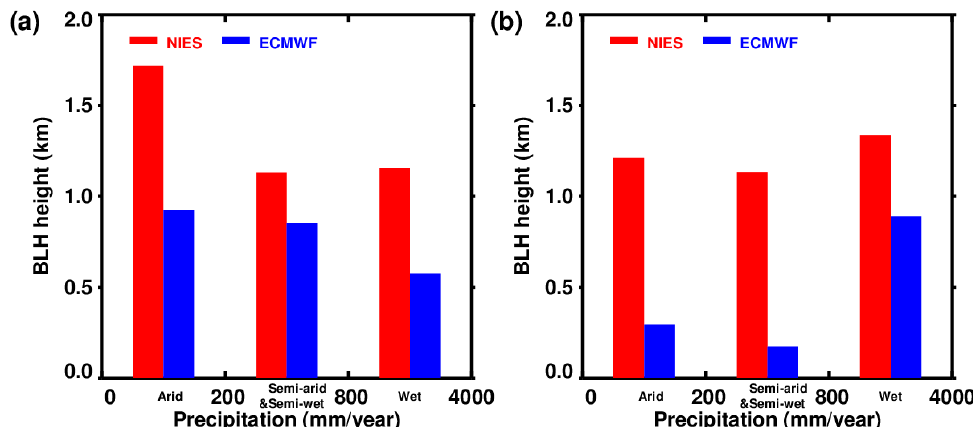
Figure 9. Comparison of AD-Net (red) and ECMWFs (blue) PBL in the case of different climate conditions (arid, semi-arid and semi-wet, and wet) for summer ( a ) and winter ( b ). Table 4. Mean differences in BLH between AD-Net and ECMWFs (ECMWFs PBL minus AD-Net PBL) in summer and winter when given different climate conditions. Semi-Arid and Arid Wet Semi-Wet Summer − 0.68 − 0.45 − 0.69 Winter − 1.42 − 0.96 − 0.27